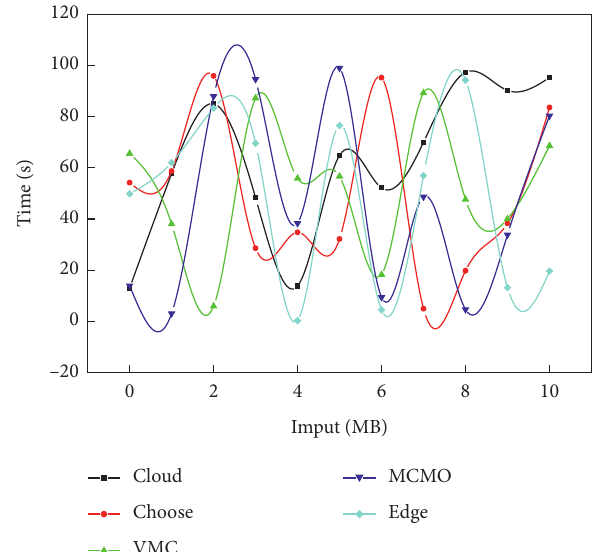
Figure 6: Impact of application input size on computational